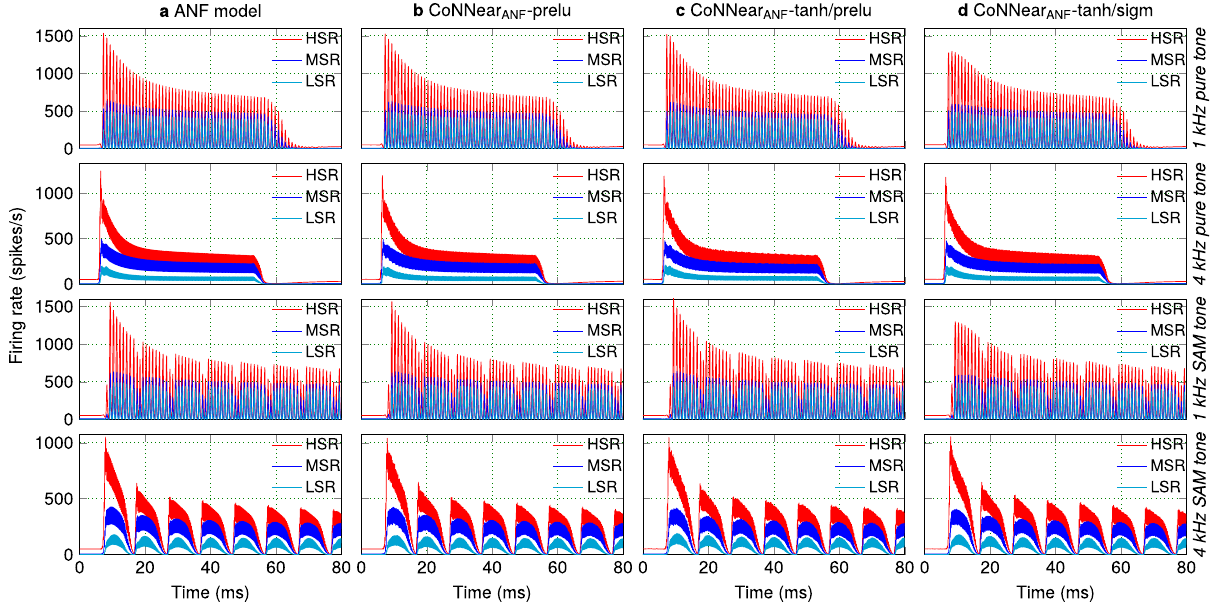
Fig. 5 Comparing fi ring rates across different ANF models (Metric 4). Simulated ANF fi ring rate across time for tone stimuli presented at 70 dB SPL. The blue, red, and cyan graphs correspond to the responses of the HSR, MSR, and LSR fi ber models, respectively. From top to bottom, the stimuli were 1 kHz, 4 kHz pure tones and 1 kHz, 4 kHz amplitude-modulated